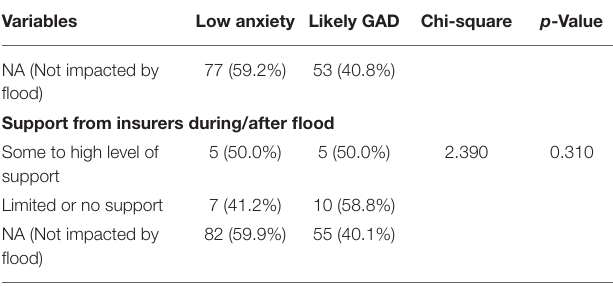
TABLE 5 | Association between participants’ source of information, degree of damage, support and likely